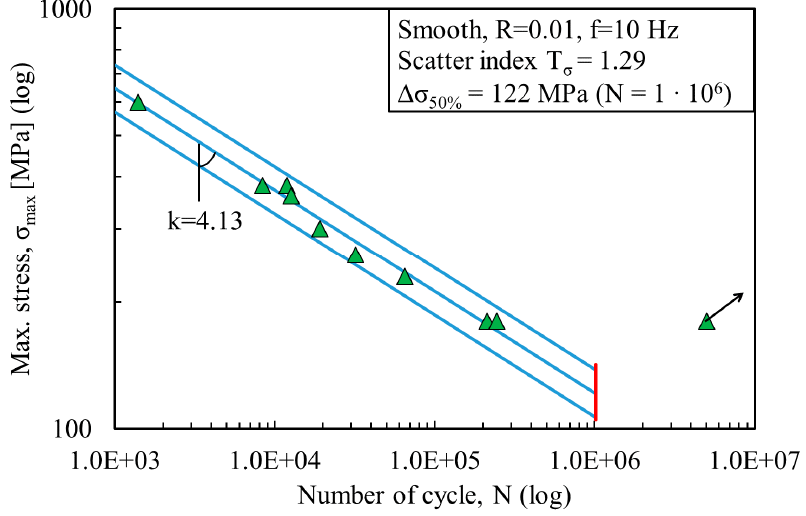
Figure 4. S-N fatigue data from LENS ® additively manufactured porous specimens.